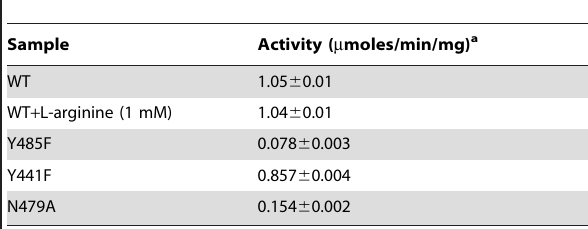
Table 4. Enzyme activities of hNAT and active site mutants.